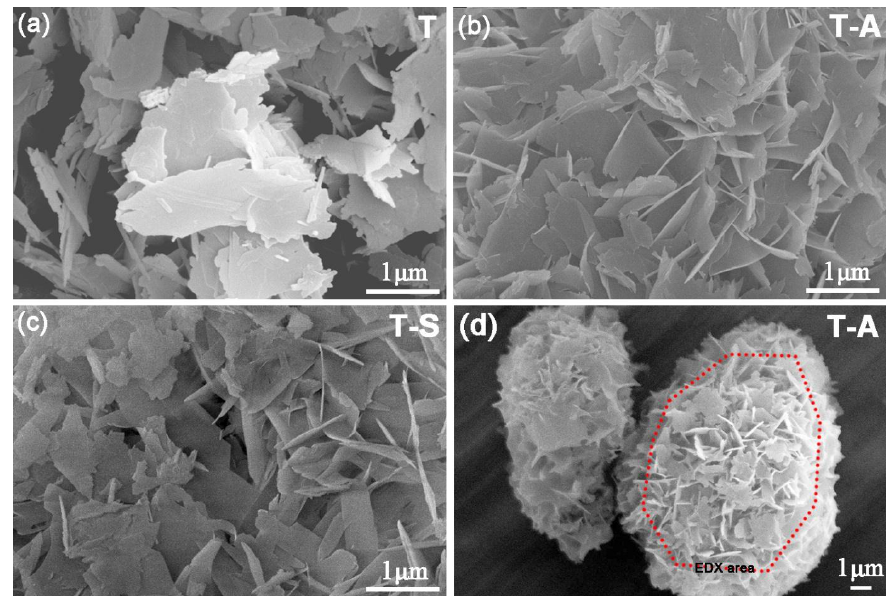
Figure 5. SEM images of the tobermorite samples: ( a ) the control sample; ( b ) and ( d ) the T-A sample; ( c ) the T-S